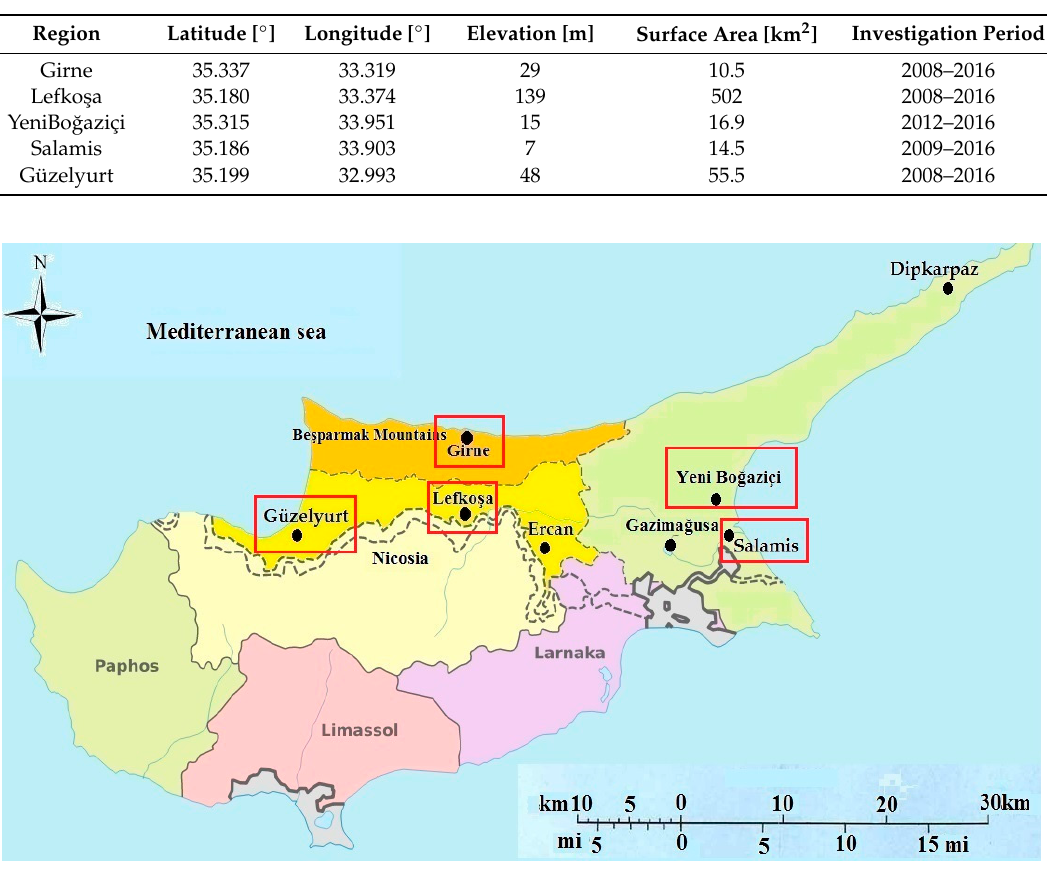
Table 1. Characteristic of the selected regions used in this study.